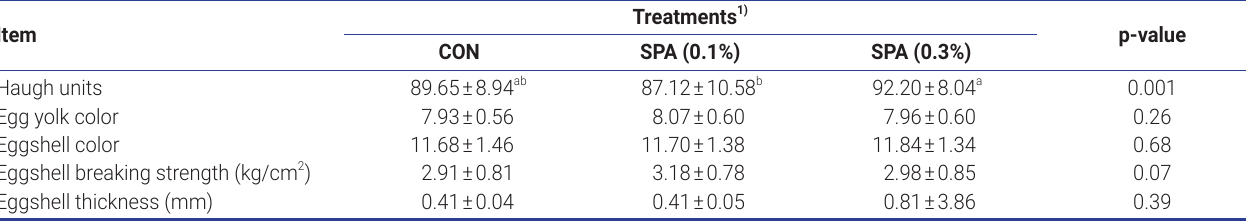
Values are means±standard error. SPA, fermented S. chinensis fruit pomace, fermented pine needle extract, and Chinese chive powder in the ratio of 2:2:1. 1)